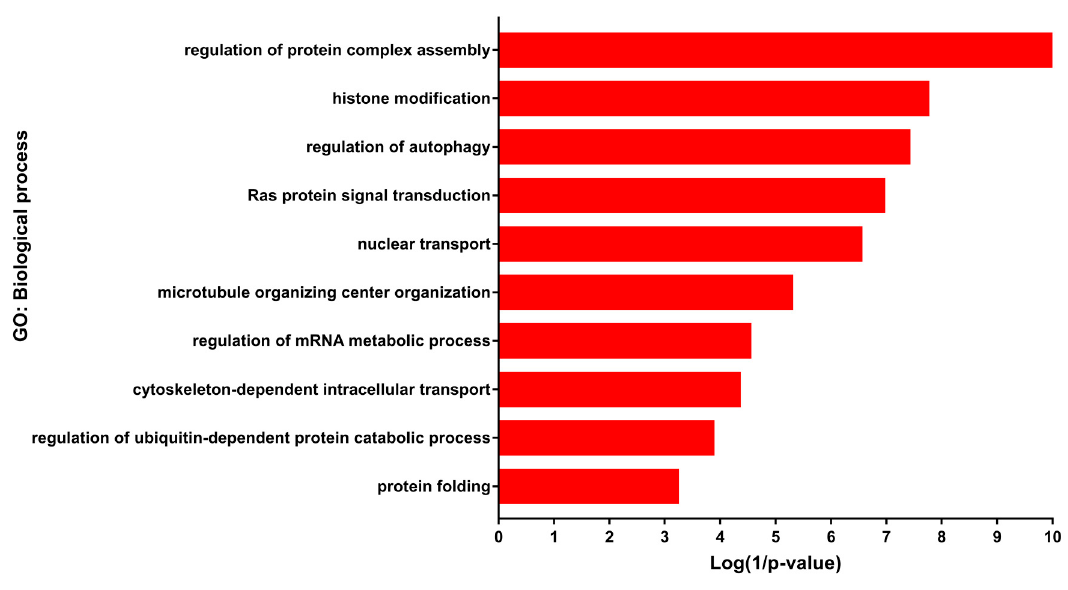
Figure 2. Gene ontology (GO) enrichment of differentially expressed genes (DEGs). Selected biological processes and their corresponding DEGs.